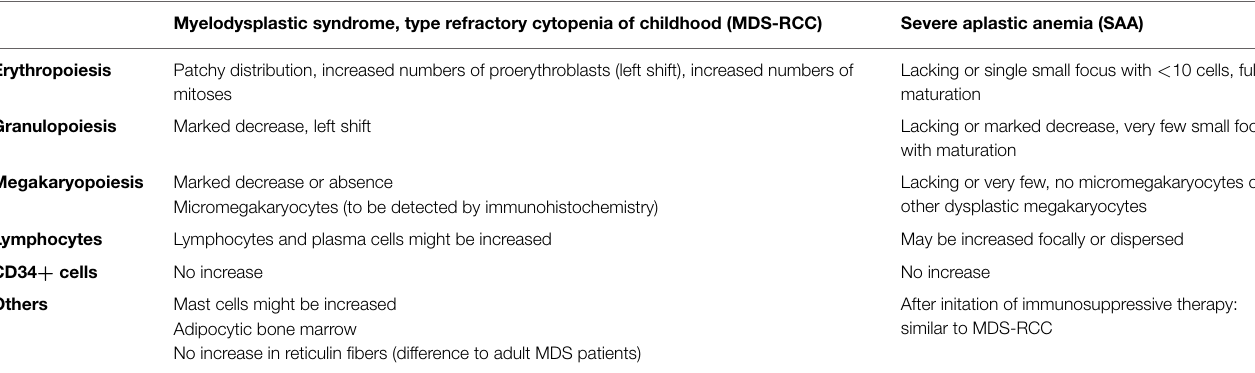
TABLE 4 | Morphological criteria for severe aplastic anemia and myelodysplastic syndromes, type refractory cytopenia of childhood (EWOG-MDS 2008) (13, 82, 113)